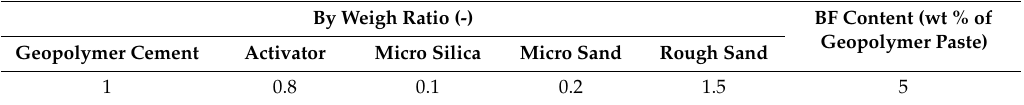
Table 2. Composition of geopolymer mortar matrix.